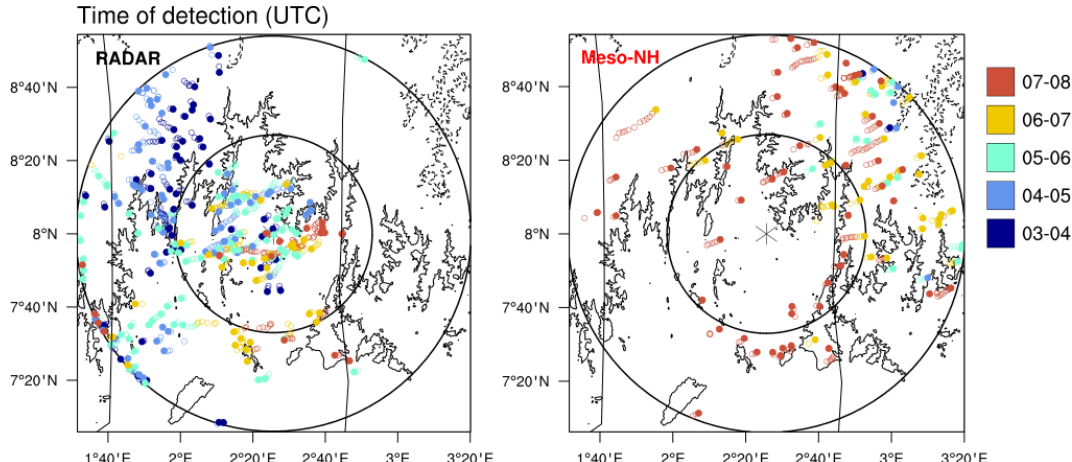
Figure 9. Spatial distribution of the tracked warm-rain cells detected by the X-band rain radar ( left ) and simulated ( right ) from 03:00 to 08:00 UTC, at a 5-min temporal resolution. The dots represent the location of the centre of mass of the warm-rain cells; the solid dots show the first detection and the open circles the rest of the trajectory for each track. Colors indicate the time when the warm-rain cells are identified.